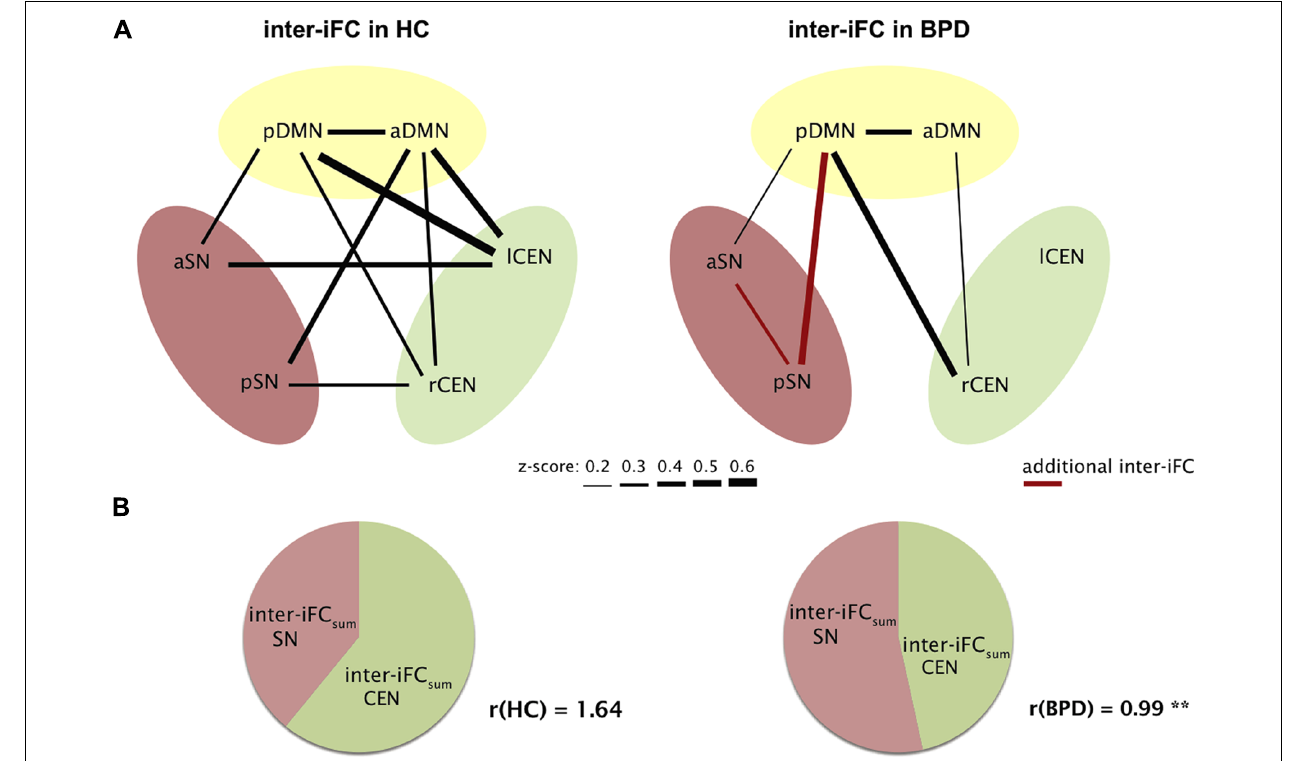
FIGURE 3 |Aberrant intrinsic functional connectivity between DMN, SN, and CEN (inter-iFC) of patients. (A) Inter-iFC between two networks is based on Pearson’s correlation between network time courses. In healthy controls (HC), black lines indicate significant inter-iFC (one-sample t -tests, p < 0.05, Bonferroni-corrected for 15 correlations).Thickness of lines reflects absolute values of Fisher- z -normalized correlation coefficients. In patients with BPD, red lines indicate increased inter-iFC compared to healthy controls, while missing lines indicate significantly reduced and absent connections in